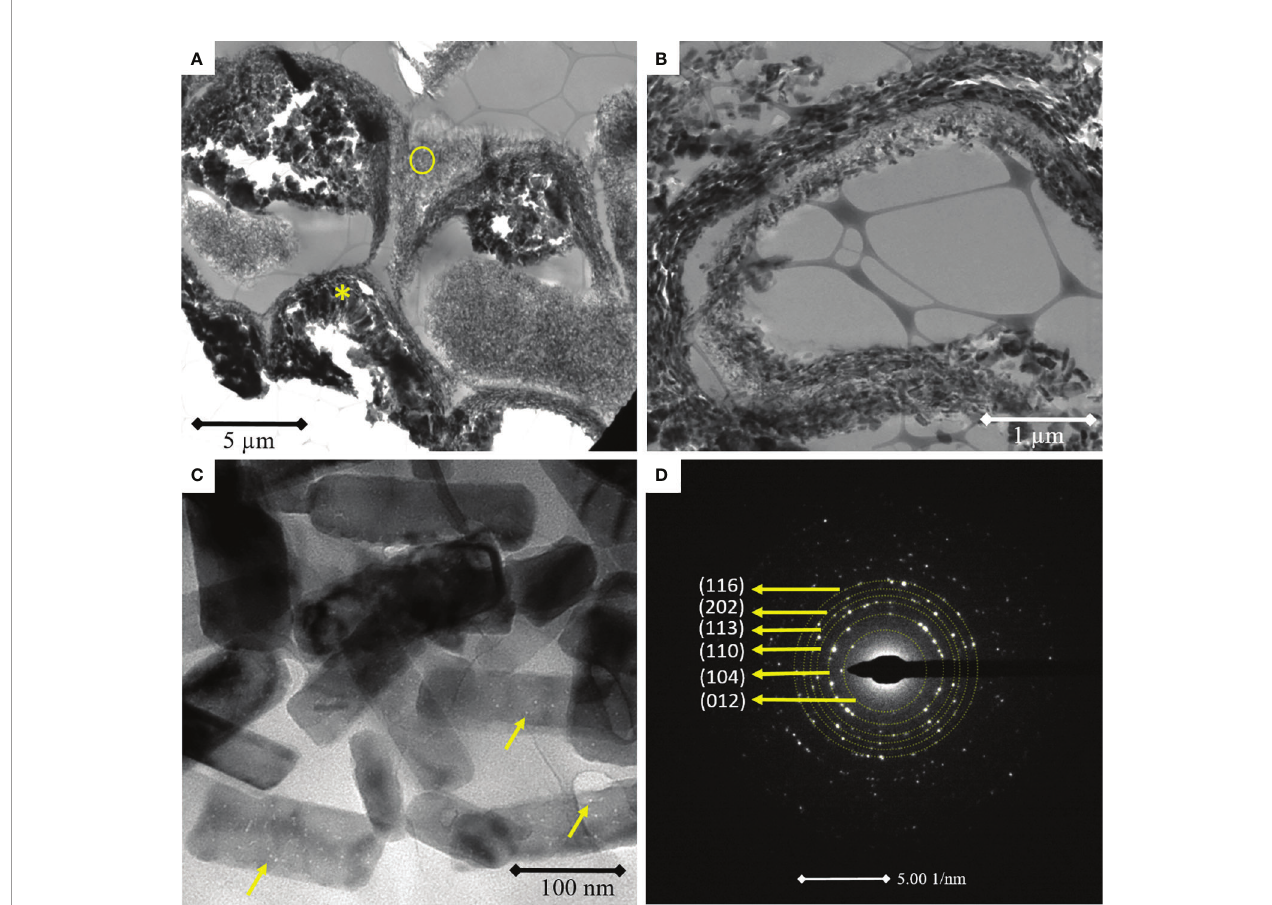
FIGURE 3 | Transmission electron microscopy images of 16 cells L. coralline germinating spore showing epithallial cells with thinner cell walls with needle-like and elongated calcite tangential crystals. Perithallial cells with thicker cell walls and perpendicular calcite crystals ( A , asterisk). Detail of the tangential crystals with different sizes and orientations (B) . Needle-like and elongated calcite nanocrystals with presence of nanopores in the crystalline structure (C) . Selected area electron diffraction (SAED) of needle-like calcite nanocrystals evidencing the random orientation and the identi fi cation of high magnesium calcite through SAED pattern indexing (D)